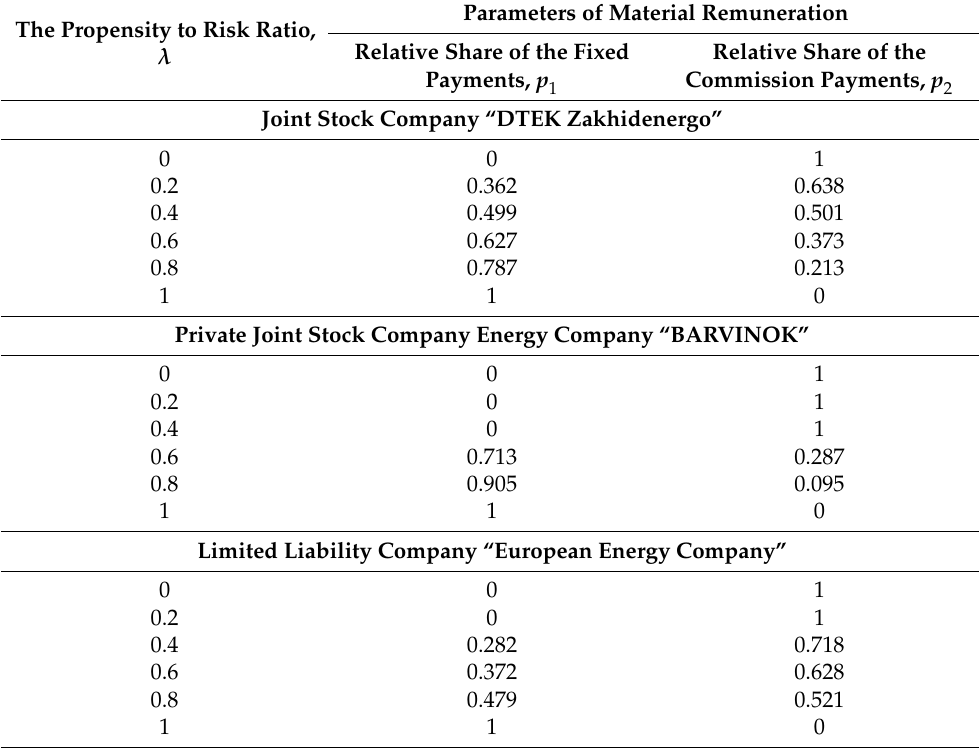
Table 3. Parameters of the optimal structure of the fixed and commission-based material remuneration package for the communication system employees of certain Ukrainian energy sector companies obtained by maximizing their utility